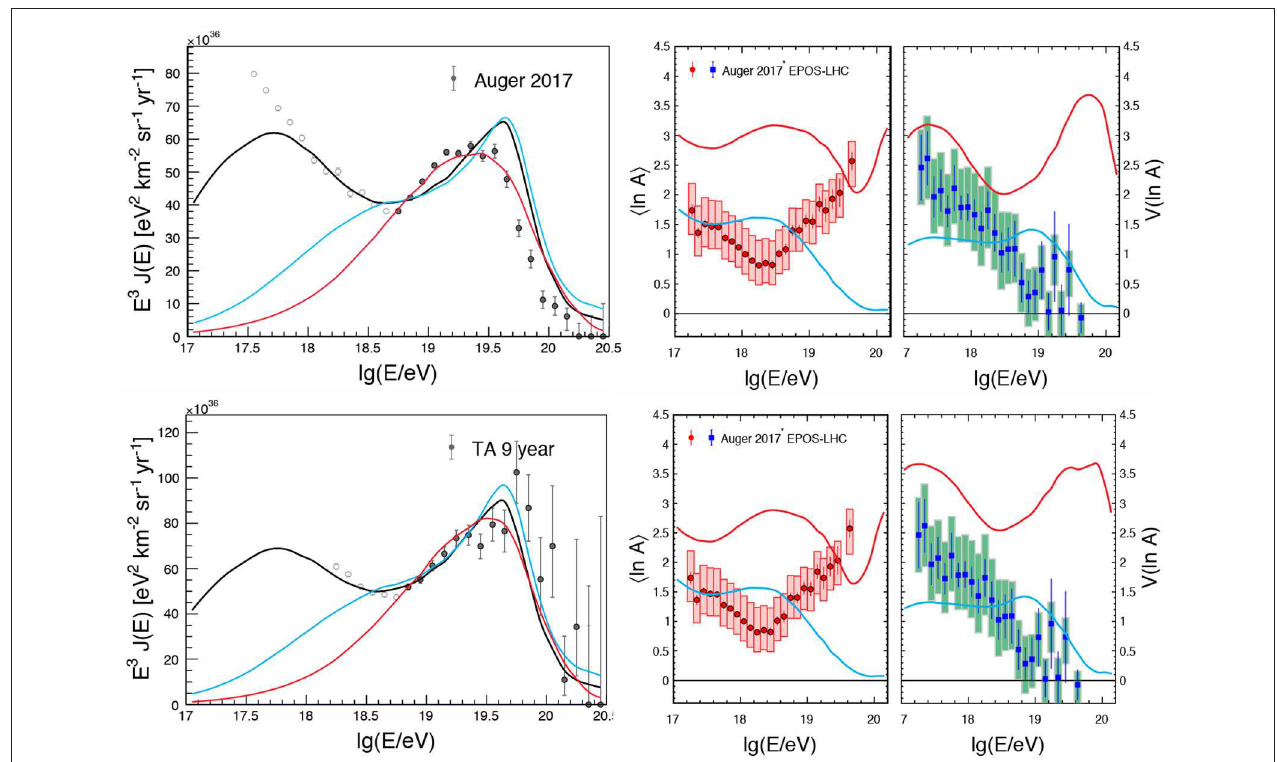
FIGURE 14 | CRPropa simulations of the energy spectrum and composition at Earth for UHECR sources injecting pure beams of protons (black lines), nitrogen A A (7 19) (blue lines), and iron-like nuclei (40 56) (red lines). The sources follow an SFR evolution and their spectra are pure power-law distributions up to ≤ ≤ ≤ ≤ 10 22 eV. For each of the primary beams, the index is chosen such as to provide the best fit to the data from Auger (Top) and TA (Bottom) . K.-H. Kampert and M. Unger for this